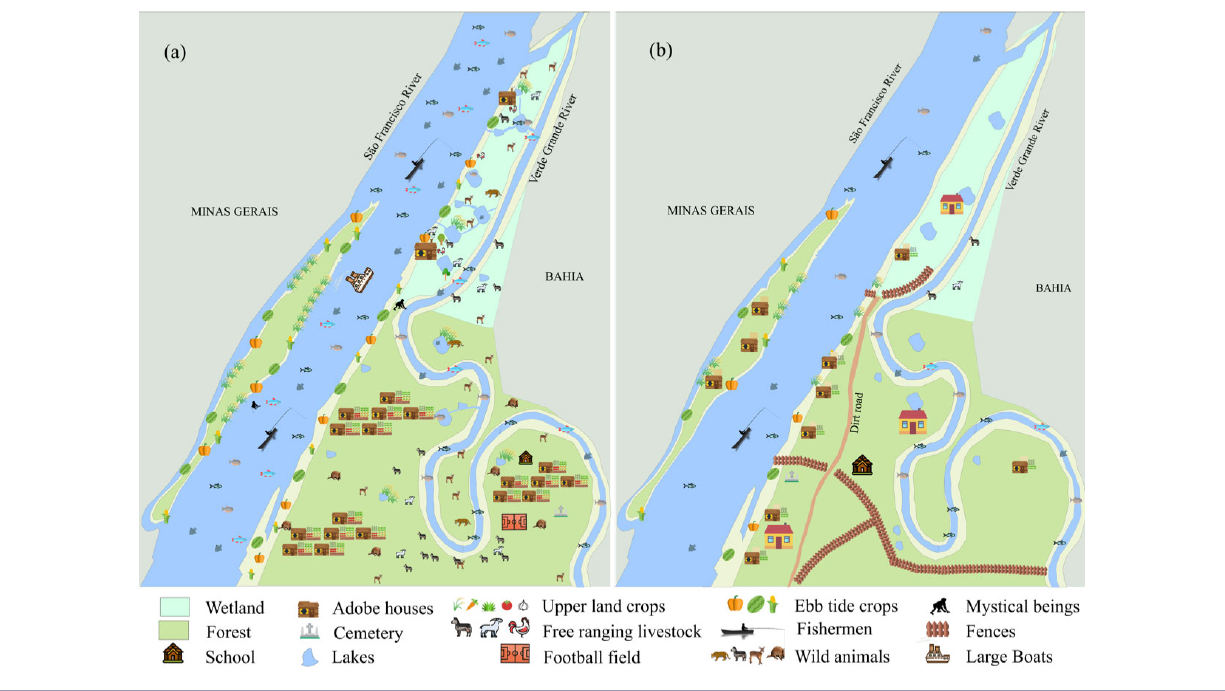
Fig. 4 . Mental maps developed with the traditional community of Pau Preto, showing its traditional territory before (A) and after (B) the expropriation first by farmers and later by the Verde Grande Park. See text for further